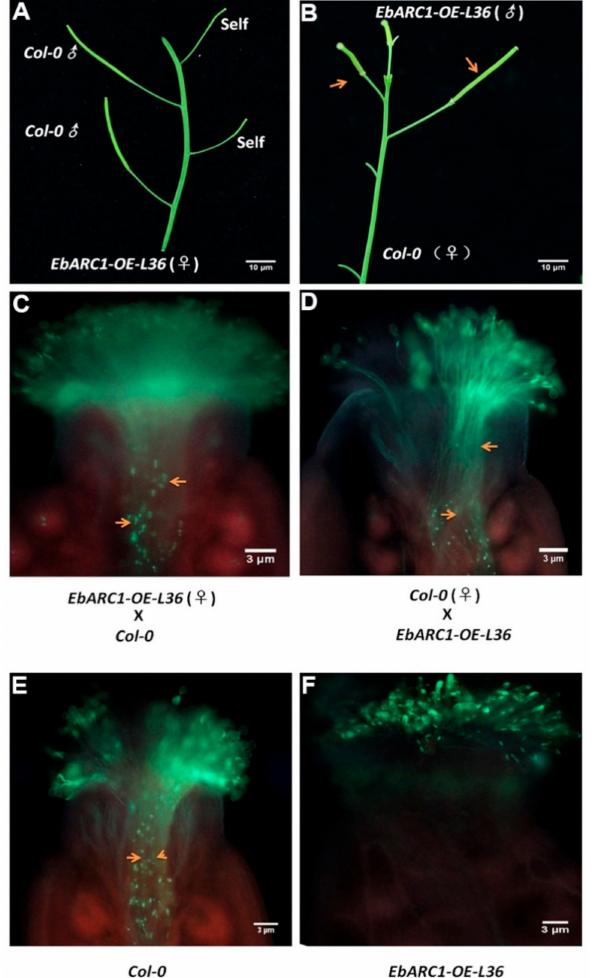
Figure 5. Overexpression of EbARC1 conferred self-incompatibility (SI) in transgenic A. thaliana . ( A ) OEARC1-OE-L36 was ( while OEARC1-OE-L36 was ( ( D ) Pollen tube staining of wild type (